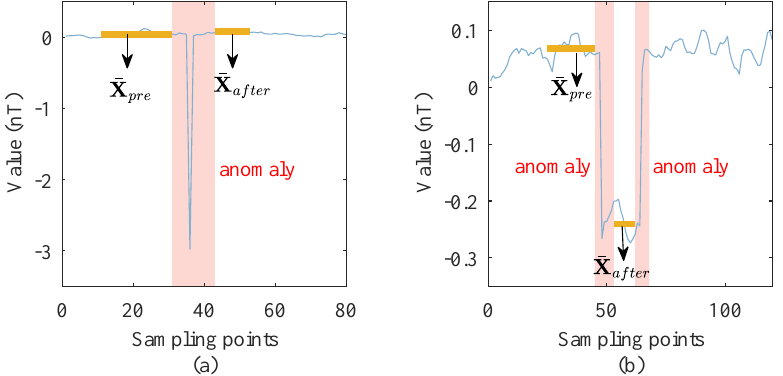
Figure 4. Detection results of two kinds of OBE interferences: ( a ) A detected short-term interference. ( b ) A detected long-term interference. The anomaly segments are marked with a red